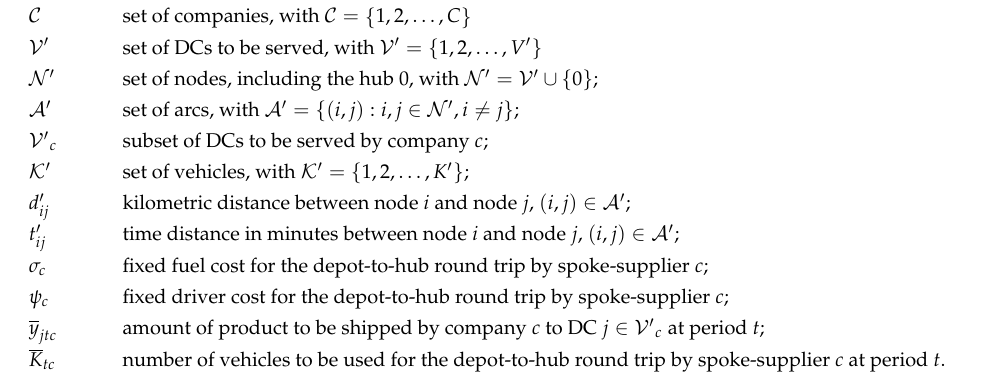
Table 3. Notation: problem